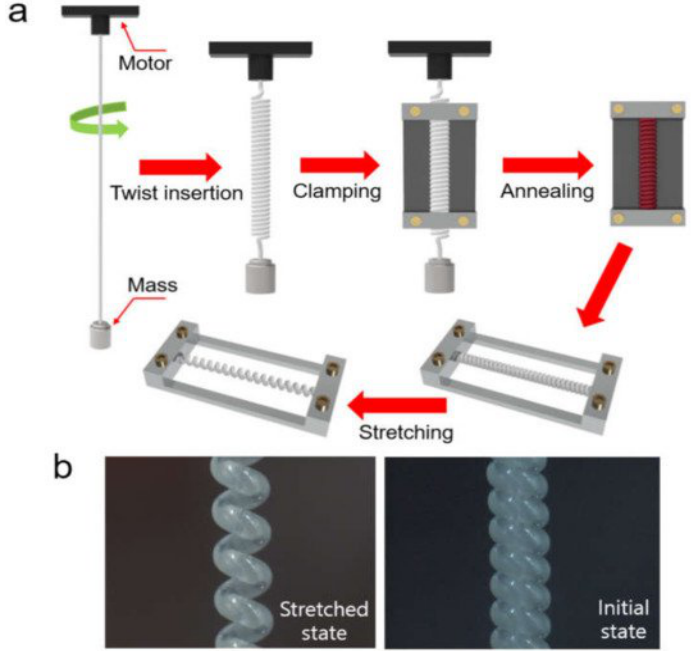
Figure 19. ( a ) diagram of the fabrication process of a TCA separated into 4 steps: twist insertion, clamping, annealing, and stretching. ( b ) Images from an optical microscope of the TCA initial and stretched state (Reprinted with permission from Hwang, I., et al. [147]. Copyright 2022, CC BY 4.0 International).